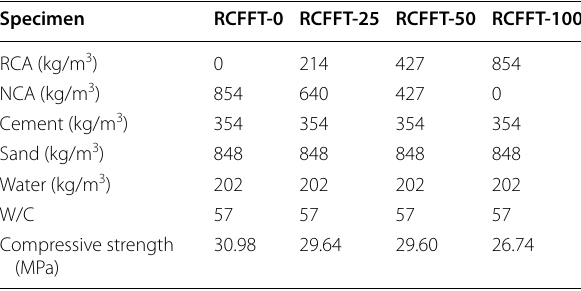
RCA recycled coarse aggregate, NCA natural coarse aggregate.